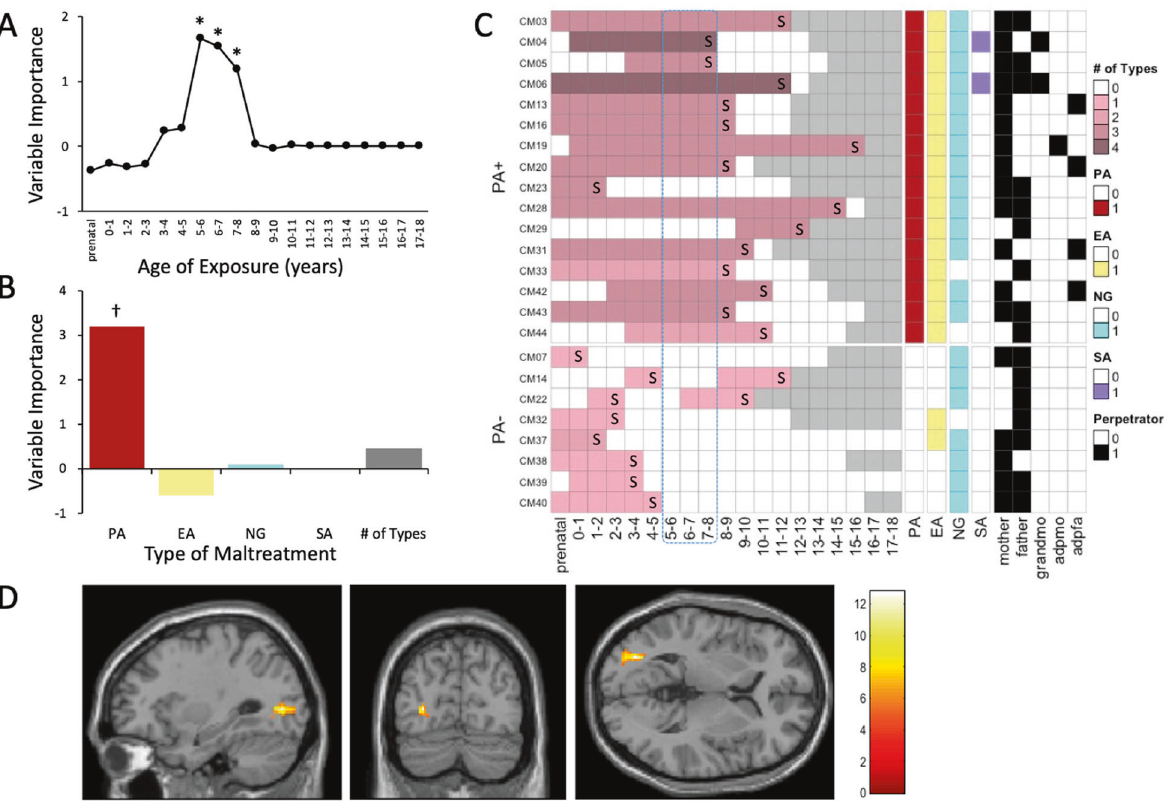
Fig. 4 Results of the sensitivity analyses for maltreatment history in CM and their impact on the brain functional connectivities. A Maximal sensitivity by age of exposure (regardless of type and number). Results of a random forest regression with conditional trees indicated the importance of exposure to early maltreatment from prenatal to 18 years of age on the OXT mi. Importance is indicated by degradation in fi t, as suggested by the increase in mean square error (MSE), following effective elimination of each age from the model by permutation. B Maximal sensitivity by type and number of maltreatments (regardless of age of exposure). * P < 0.05 (uncorrected). † P < 0.10. C Structure of maltreatment history for each individual. Gray block: Not to reach the age, S sheltered, PA physical abuse, EA emotional abuse, NG neglect, SA sexual abuse, mother: biological mother, father: biological father, grandmo: grandmother, adpmo: adoptive mother, adpfa adoptive father. D PA + ( n = 7) vs. PA − ( n = 4) comparison for resting state fMRI (rs-fMRI). The color bar denotes the T -statistic